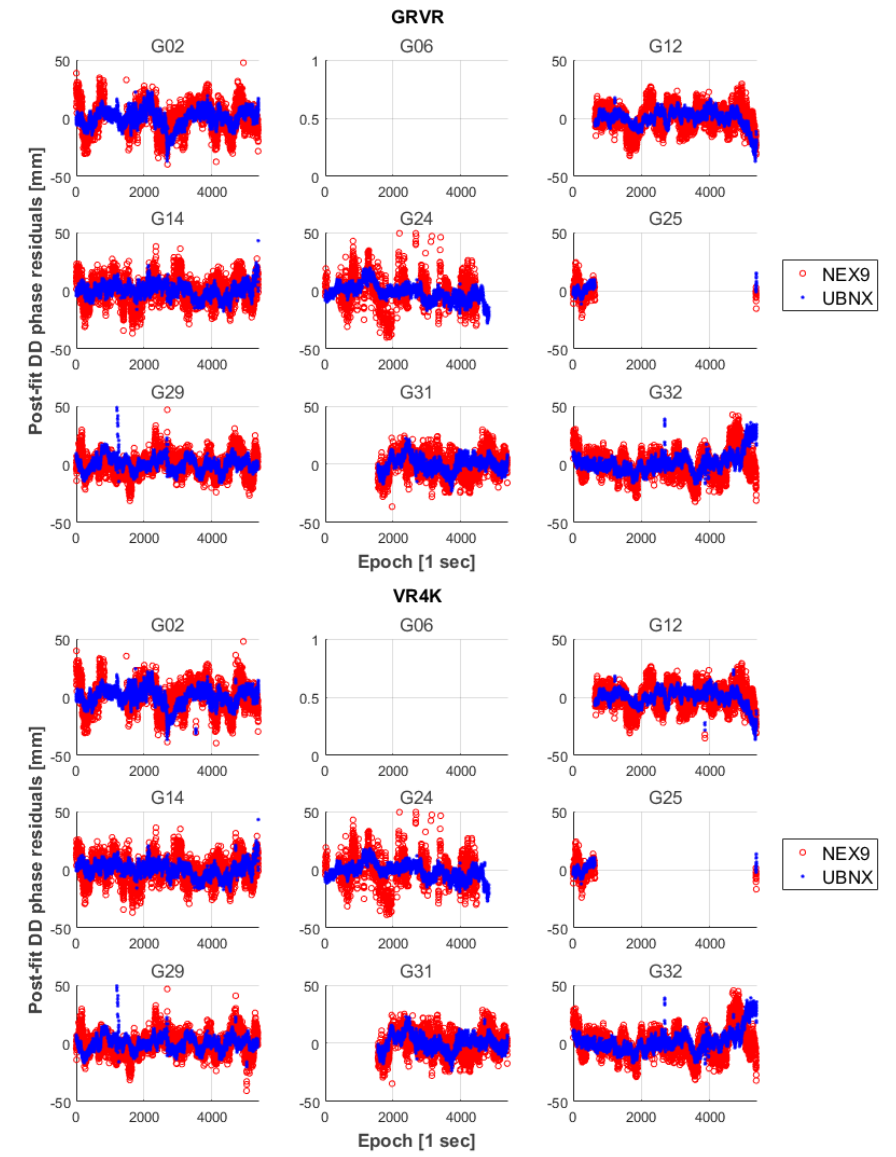
Figure 6. Post-fit double difference phase residuals of the float solutions for the baseline with respect to the two virtual